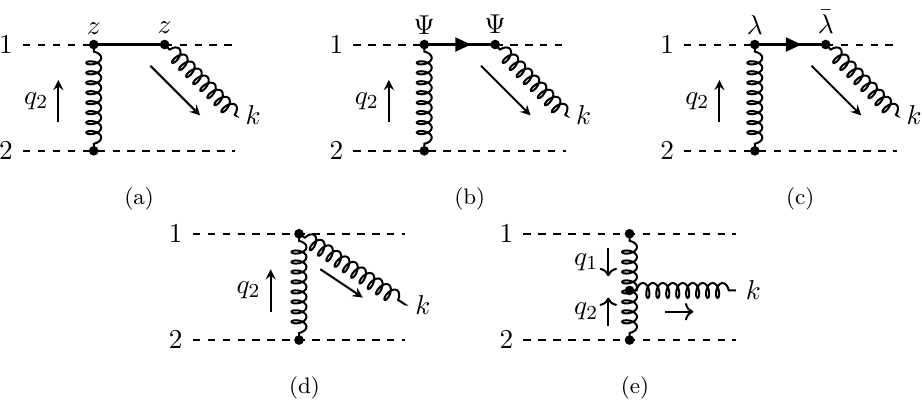
Figure 2 . Topologies contributing to the leading Yang-Mills radiation for spinning worldlines. For 2c, we also need to include the crossed diagrams that can be obtained by simply reversing the arrows on the worldline. For 2a–2d, we also need to include diagrams with 1 and 2